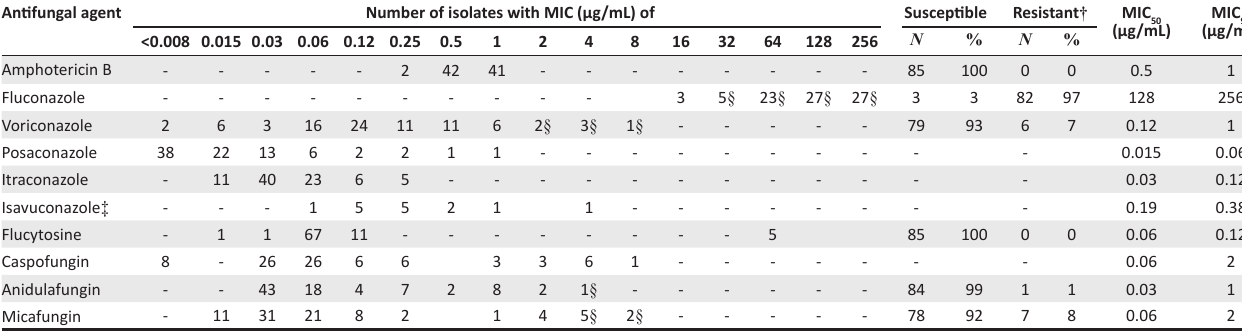
TABLE 1: Antifungal susceptibility profile of Candida auris isolates ( n = 85). Antifungal